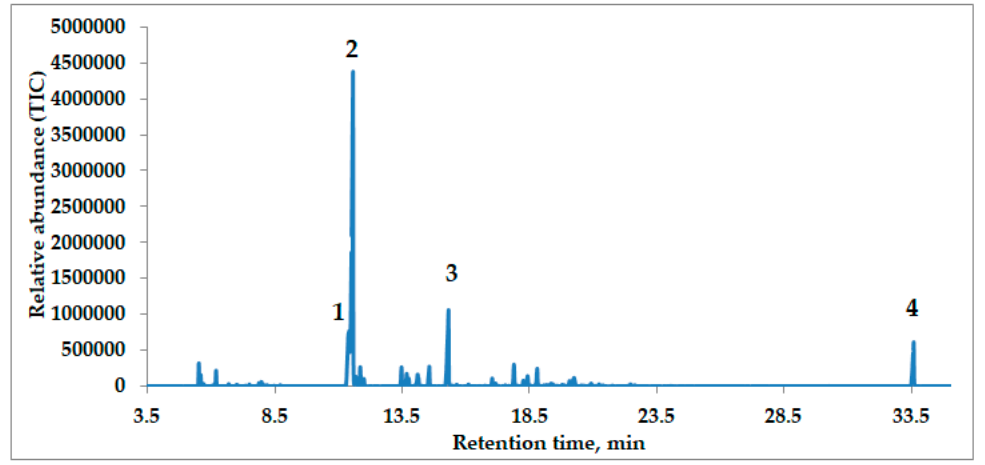
Figure 2. The GC-MS chromatogram of the volatile oil of Prangos pabularia . 1. menthone; 2. 5-pentylcyclohexa-1,3-diene; 3. 1-tridecyne; 4. osthole.